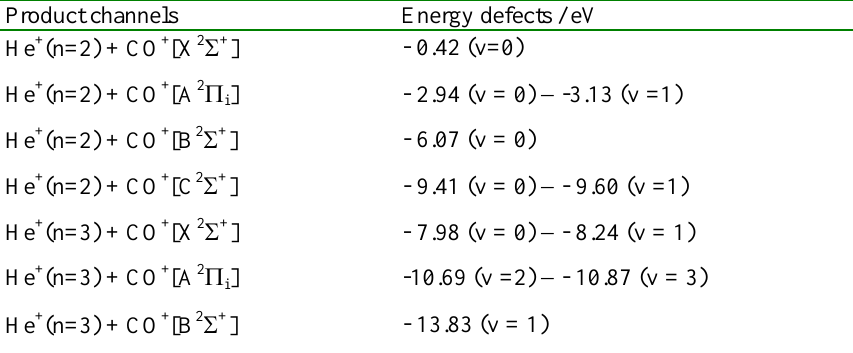
Table 4. Main endothermic product channels for the He 2+ + CO 1 Σ +